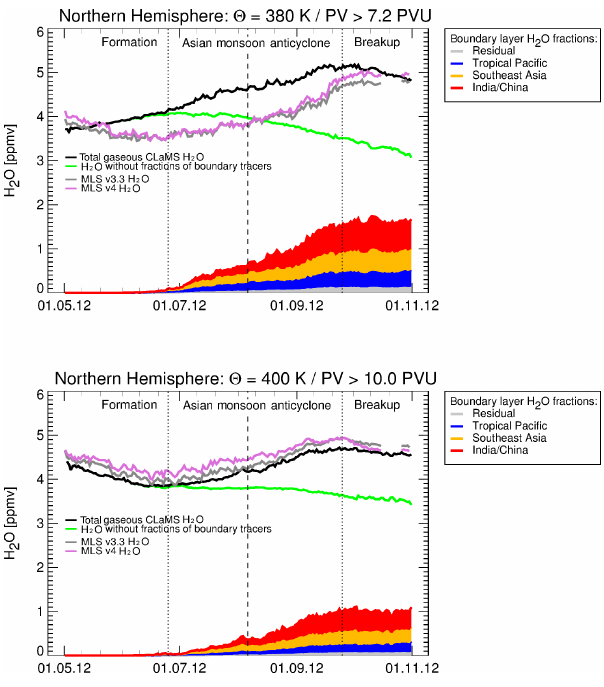
Figure 15. The increase of H 2 O mixing ratios in the lower North- ern Hemisphere stratosphere at 380K (top) and at 400K (bottom) during summer 2012 is shown (black line). The green line indi- cates H 2 O mixing ratios without fractions from the Earth’s bound- ary layer. Mean H 2 O mixing ratios derived from MLS version v3.3 (gray) and version v4 (purple) in the northern extratropical lower stratosphere also show an increase in water vapor during summer and autumn. A rough estimation of the fraction of H 2 O mixing ra- tios originating in India/China (red), southeast Asia (yellow), and the tropical Pacific Ocean (blue) in the northern lower stratosphere is also